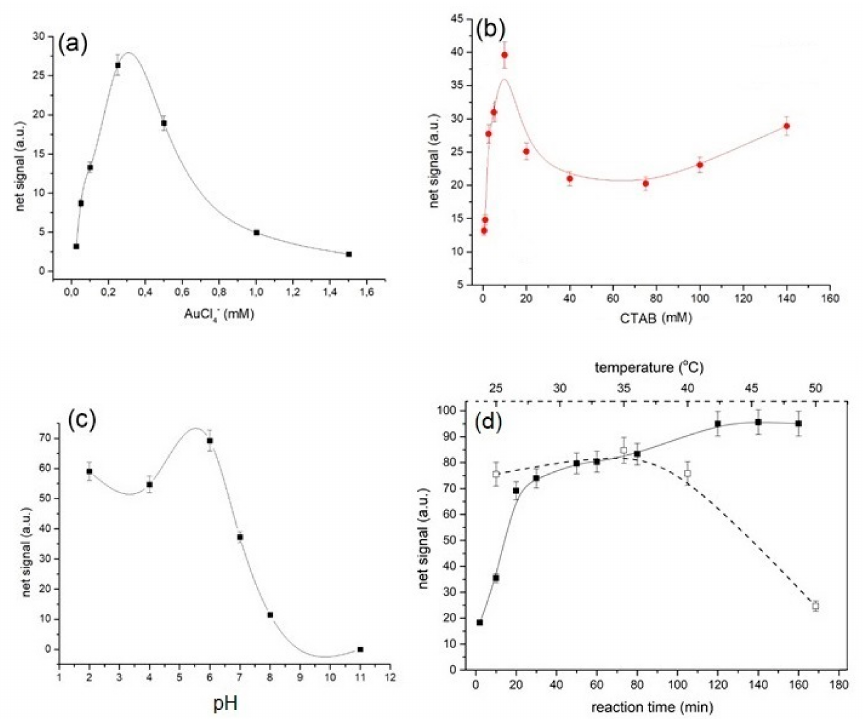
Figure 3. Optimization of the experimental conditions: ( a ) AuCl 4 − concentration (other conditions: 75 mM CTAB, 50 µ M Cys, no buffer, room temperature, reaction time 30 min); ( b ) CTAB concentration (other conditions: 0.25 mM AuCl 4 − , 50 µ M Cys, no buffer, room temperature, reaction time 30 min); ( c ) pH (other conditions: 0.25 mM AuCl 4 − , 10 mM CTAB, 50 µ M Cys, no buffer, room temperature, reaction time 30 min); ( d ) reaction time and temperature (other conditions: 0.25 mM AuCl 4 − , 10 mM CTAB, 50 µ M Cys, sodium acetate/acetic acid buffer pH